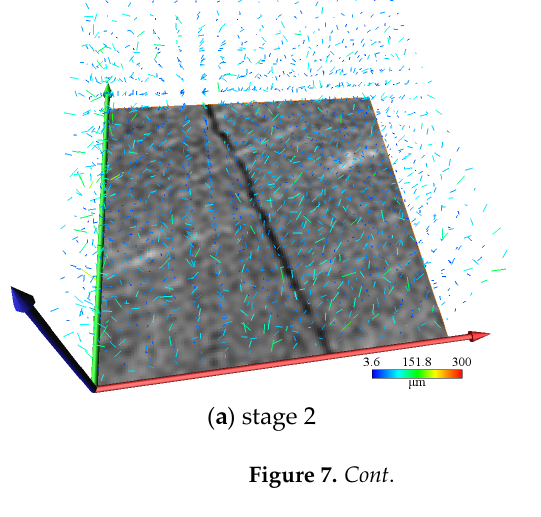
The ROIs for each scanning stage were compared with that of the initial state by using the digital volume correlation module of the Avizo software (i.e., scanning stage 1). Seven sets of calculation results were obtained for each ROI, as shown in Figure 7. Figure 7a corresponds to the displacement field of the second loading stage, and so on.